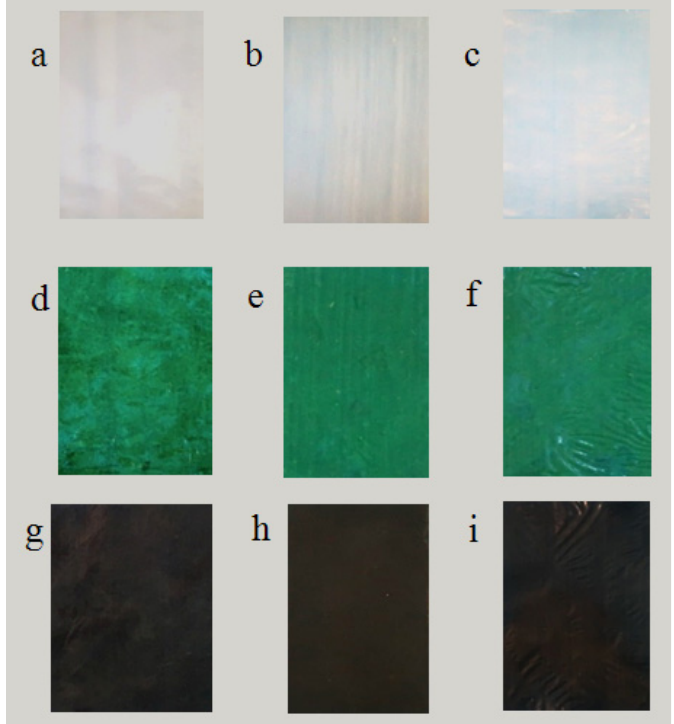
Figure 4. Photographs of porous PE ( a ), PP ( b ), and PVDF ( c ) supports; PANI ( d – f ) and PPy ( g – i ) coatings onto PE ( d , g ), PP ( e , h ), and PVDF ( f , i ) supports.